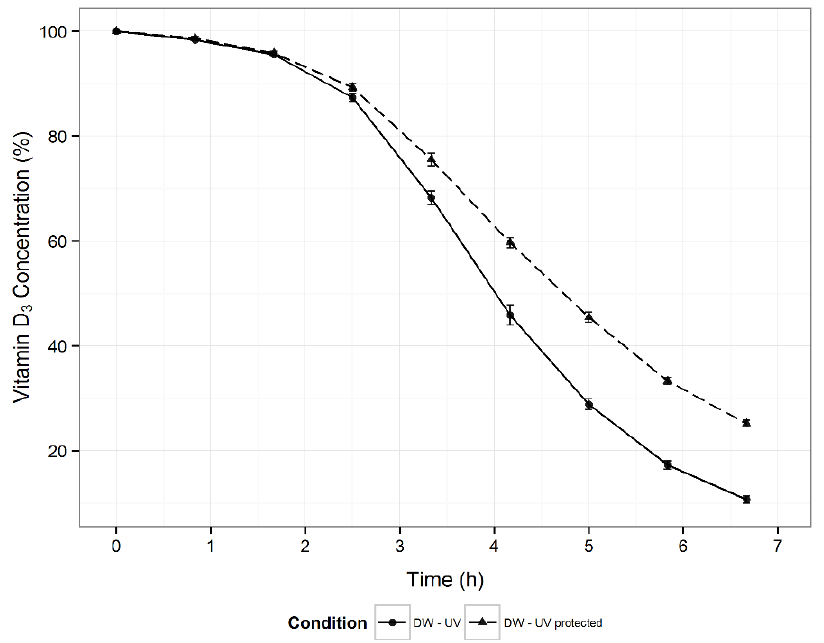
Figure 3. Stability of vitamin D3 in distilled water solutions exposed to light (DW–UV) and protected from light (DW–UV protected) at 25 °C ( n = 5).